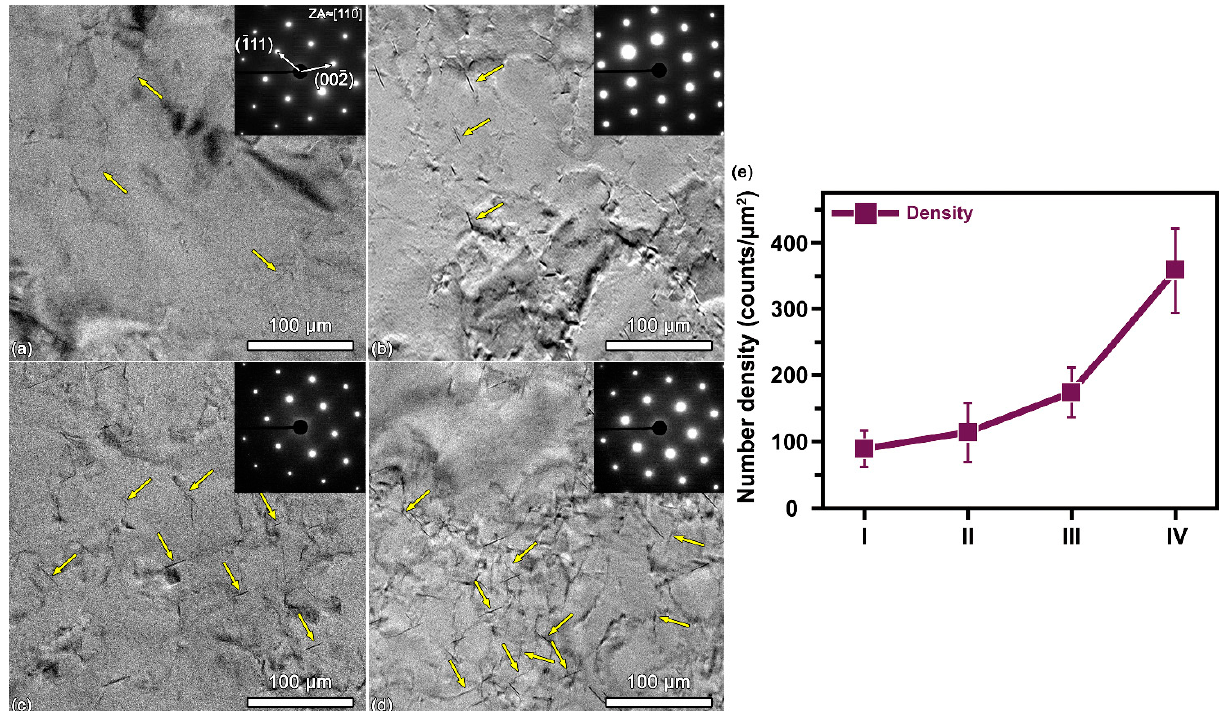
Figure 7. ( a – d ) Medium-magnification BF images and corresponding electron diffraction results recorded at the {110} Al zone axis: ( a ) sample I, ( b ) sample II, ( c ) sample III, ( d ) sample IV, and ( e ) number density of hardening phases ( θ ’ and Ω ) with respect to T sol.